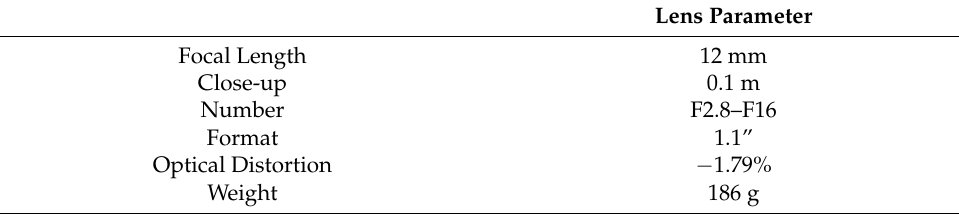
Table 2. Main parameters of the